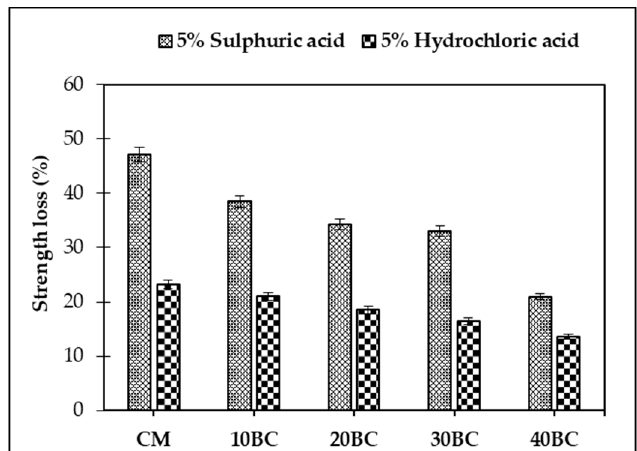
Figure 15. Strength loss of concrete mixes subjected to acid attack.